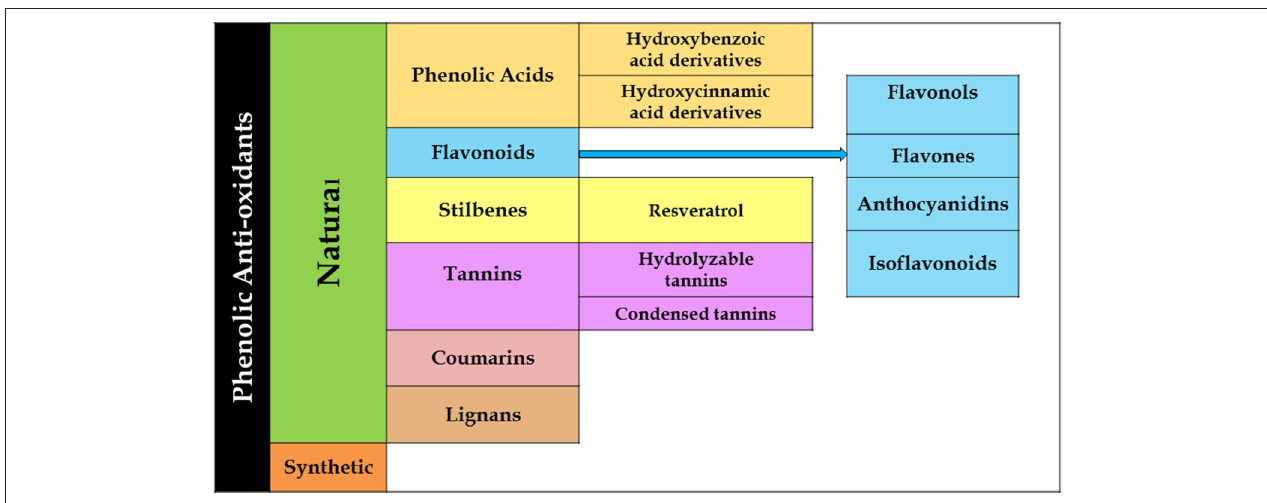
FIGURE 4 | Flowchart showing various descendants of the phenolic